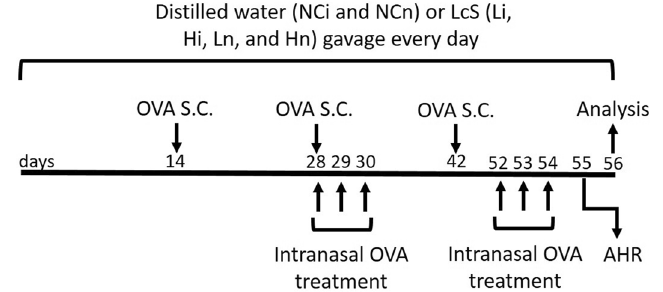
Figure 8. Schematic illustration of the experimental protocol. Briefly, BALB/c mice received either distilled water or Lactobacillus casei Shirota fermented beverage (LcSFB) every day. Ovalbumin (OVA) was given to all groups by subcutaneous (s.c.) injection on the 14th, 28th, and 42nd days. Moreover, the NCn, Ln, and Hn groups were treated with OVA via the intranasal route on the 28th, 29th, 30th, 52nd, 53rd, and 54th days. Airway hyperresponsiveness (AHR) was assessed in the NCn, Ln, and Hn groups on the 55th day. The mice were sacrificed on the 56th day, and the proliferation of splenocytes, percentages of regulatory T (Treg) and T helper (Th) lymphocytes in splenocytes, OVA ‐ specific antibodies, and cytokines were